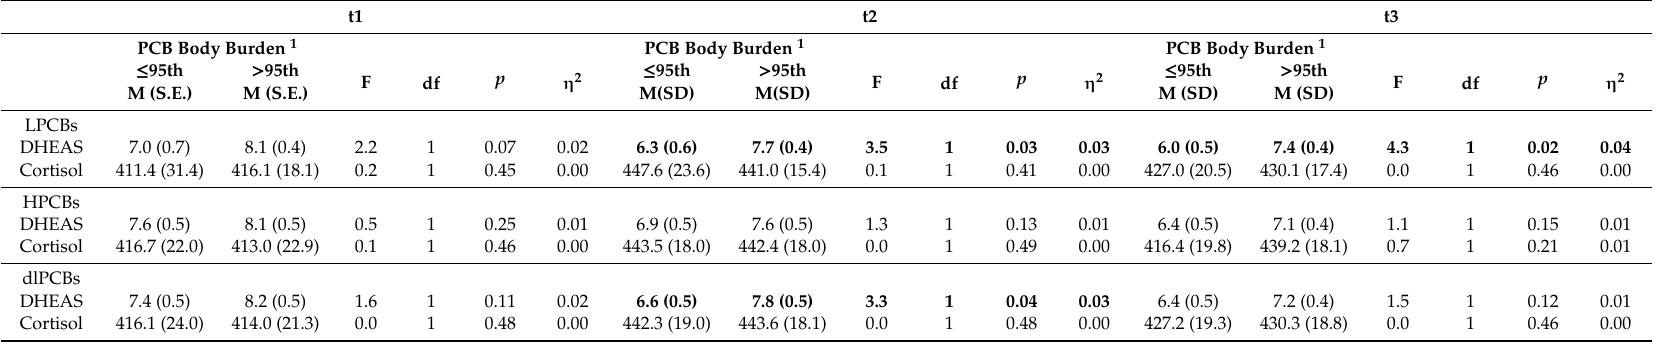
Table 5. Comparison of mean stress hormone concentrations between normal and higher-burdened participants ( N = 112). t1 t2 t3